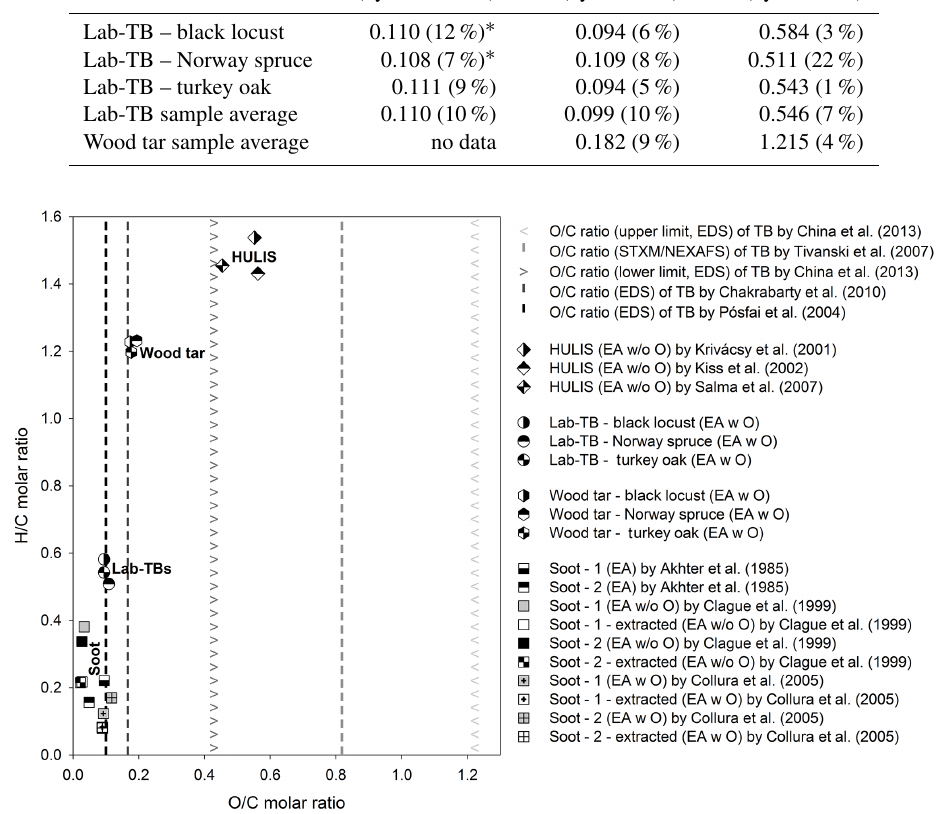
Figure 1. Van Krevelen diagram of different soot (Akhter et al., 1985; Clague et al., 1999; Collura et al., 2005), Lab-TB, wood tar and HULIS (Krivácsy et al., 2001; Kiss et al., 2002; Salma et al., 2007) samples. The elemental compositions were measured by energy-dispersive X-ray spectroscopy (EDS), scanning transmission X-ray microscopy with near-edge X-ray absorption fine structure spectroscopy (STXM/NEXAF), or different elemental analysis techniques with or without direct oxygen measurement (EA, EA w O, EA w/o